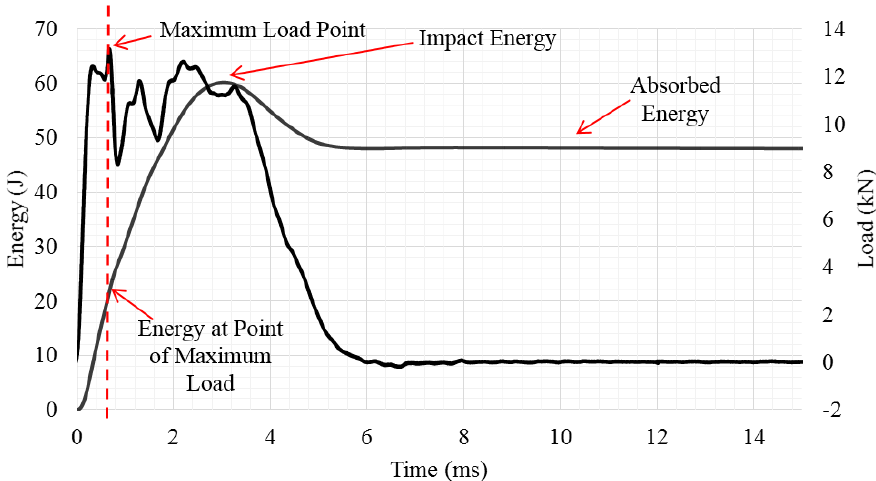
Figure 3. Typical load and energy versus time curve and characteristic points for post-impact analysis.